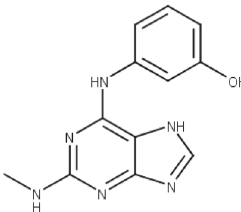
FIGURE 11 - Inhibitor of the enzyme c-SRC, which also acts on the DENV NS5 protein.